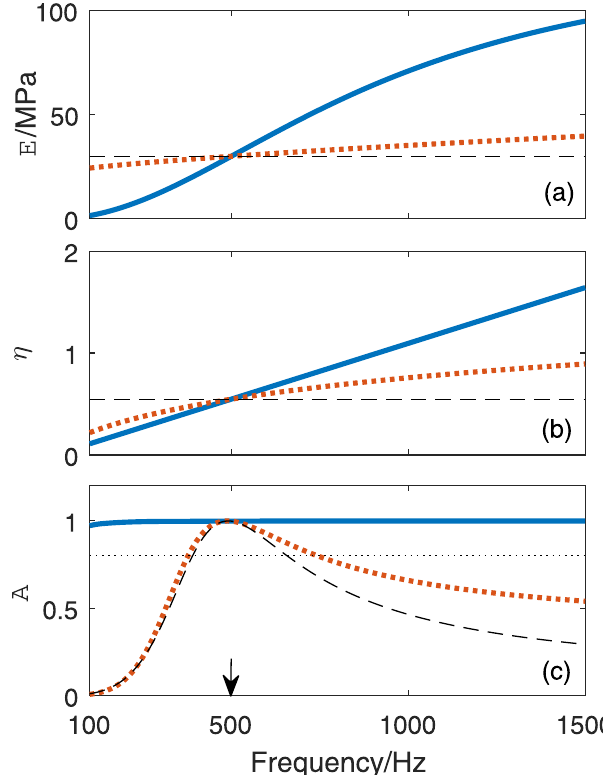
Figure 5. The frequency-dependent ( a ) dynamic modulus E and ( b ) loss factor η of the Young’s modulus of rubber matrix and ( c ) the corresponding sound absorption of the cavity-based metasurface (designed at f p = 500 Hz). : Theoretical requirements for broadband perfect